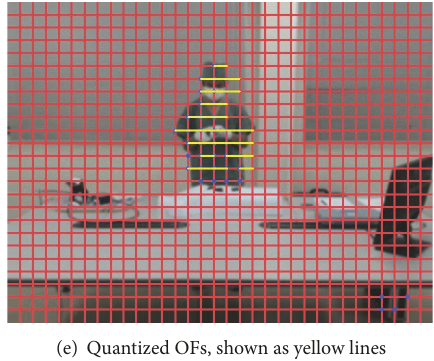
Figure 4: Example outputs of all steps in the GridIntersect